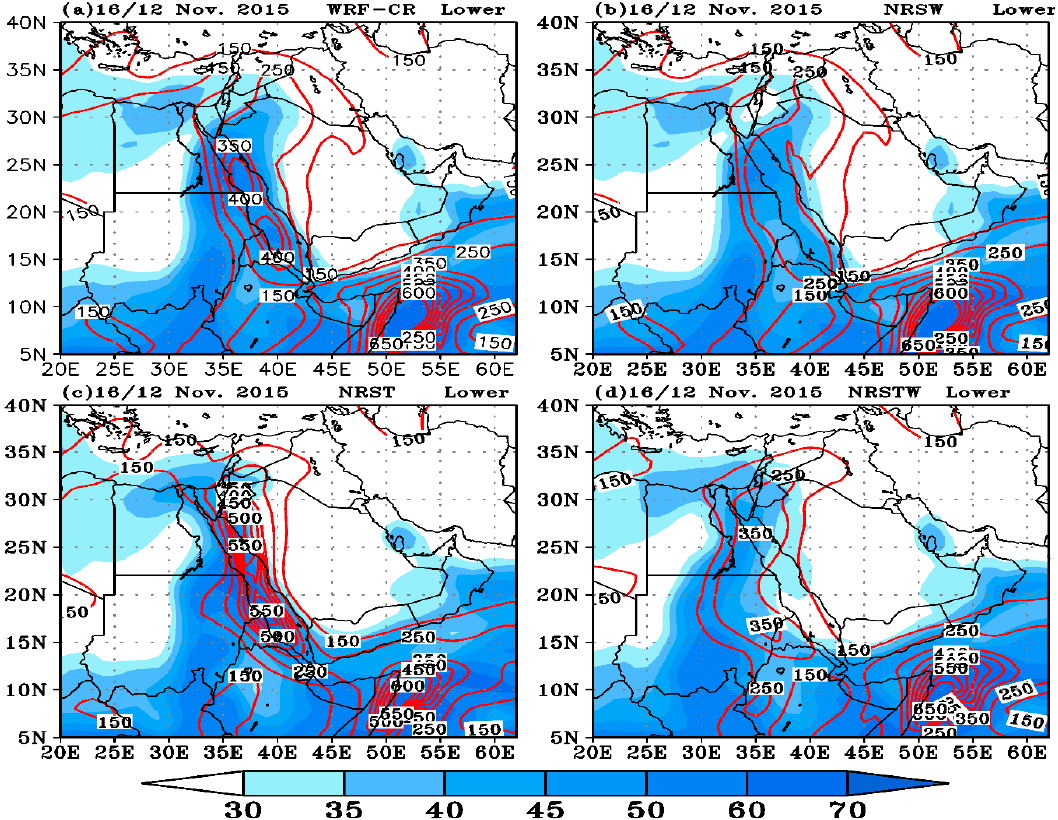
Figure 14. Rotational component of integrated moisture-flux (red contours, kg m − 1 s − 1 ) for ( a ) WRF-CR, ( b ) NRSW, ( c ) NRST, and ( d ) NRSTW, along with precipitable water content (shaded; mm) in the lower tropospheric layer (1000-850 hPa) on 12:00 UTC 16 November 2015.